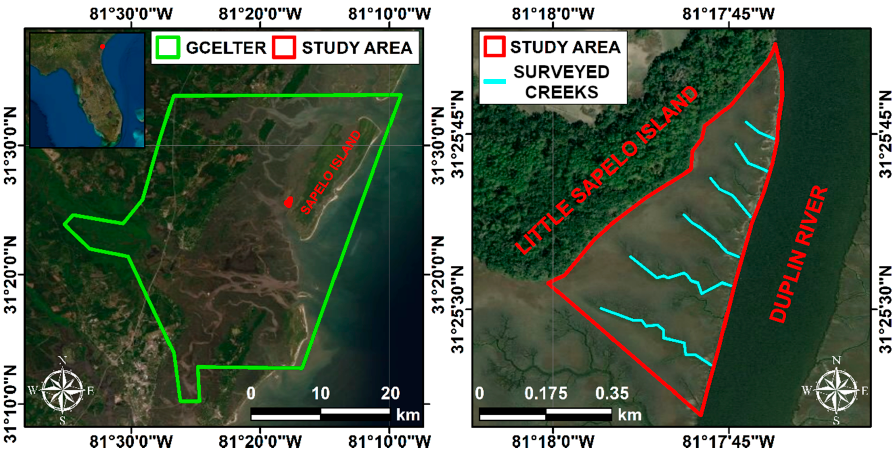
Figure 1. Location of the salt marsh in Little Sapelo Island, Georgia, USA, in the Georgia Coastal Ecosystem Long Term Ecological Research (GCELTER). The cyan lines indicate the main creeks surveyed in our study and crossing the study